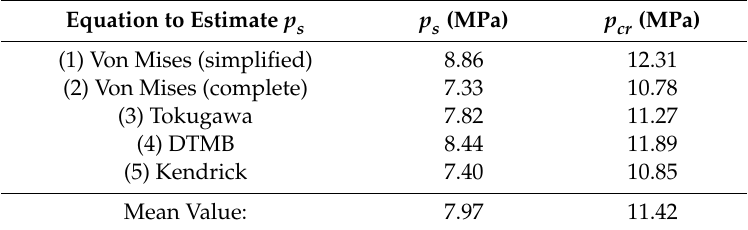
Table 3. Calculated critical pressures for the conventional sti ff ened shell using analytical formulations. Equation to Estimate p s